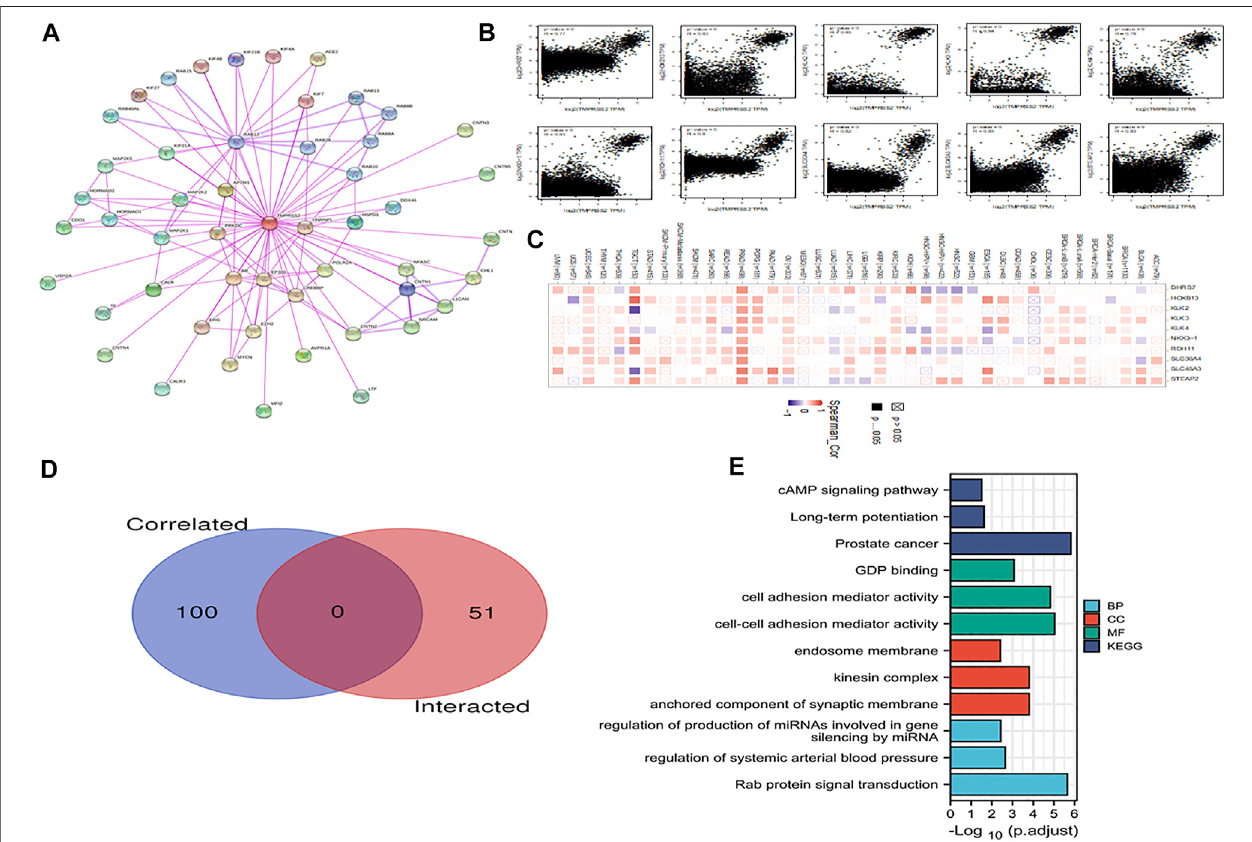
FIGURE 13 | Enrichment analysis of TMPRSS2-related genes. (A) The STRING tool was utilized to obtain available TMPRSS2 binding proteins. (B) Using the GEPIA2 method, we also obtained the top 100 TMPRSS2-related genes in the TCGA project, including DHRS7, HOXB13, KLK2, KLK3, KLK4, NKX3-1, RDH11, SLC30A4, SLC45A3, and STEAP2. (C) The plot demonstrates the correlation data between TMPRSS2 and the related top 10 genes in various cancers. (D) Cross- analysisofTMPRSS2bindinggenesandrelatedgeneswasperformed. (E)